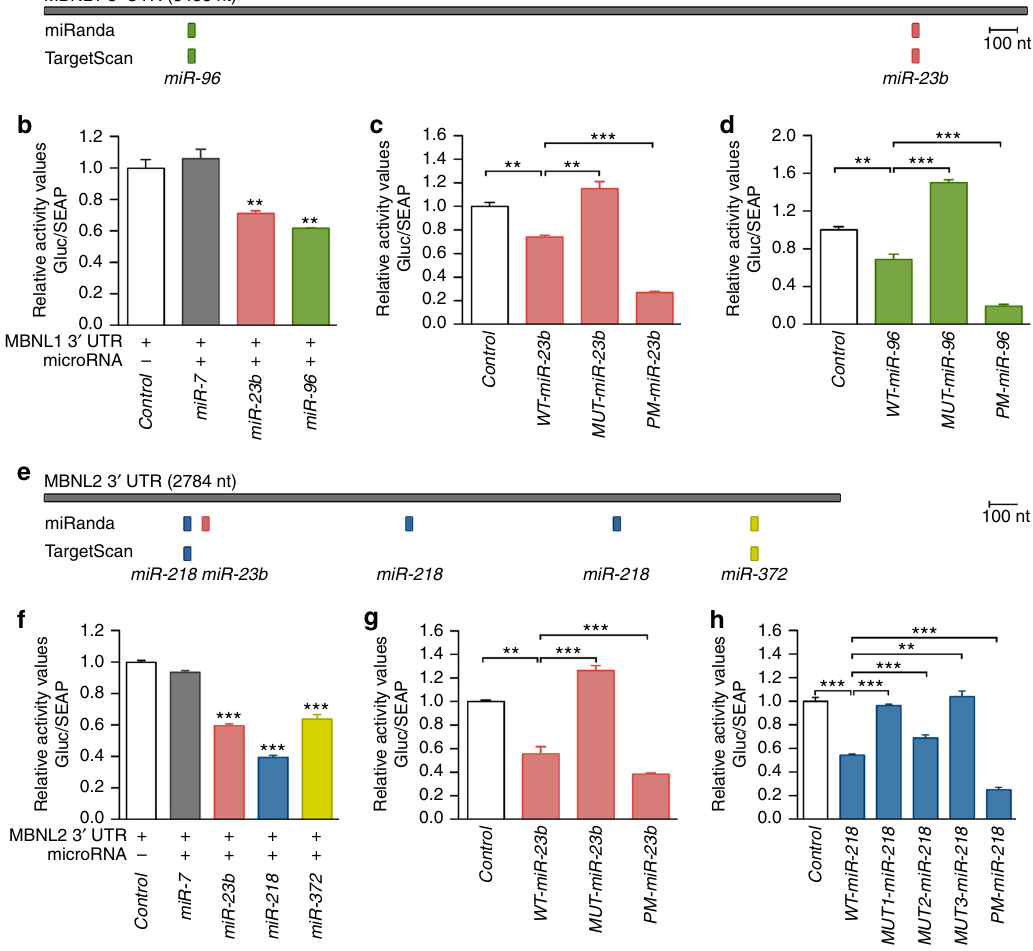
Fig. 2 Con fi rmation of miRNA binding to MBNL1 and MBNL2 3 ′ UTRs. a , e Scale representation of MBNL1 ( a ) and MBNL2 ( e ) 3 ′ UTRs and predicted miRNA binding sites according to miRanda and TargetScan algorithms. MBNL1 ( b – d ) and MBNL2 ( f – h ) 3 ′ UTR luciferase reporter assays of HeLa cells co- transfected with wild-type ( b , f ) or mutated ( c , d , g , h ) versions of 3 ′ UTR fused to Gaussia luciferase and miRNA plasmids ( n = 4). miR-7 was used as a negative control. Wild-type (WT) reporter plasmids had the natural sequence of the miRNA binding sites, mutated (MUT) constructs lacked a candidate miRNA seed region recognition site and the perfect match (PM) versions had the miRNA binding site replaced by the full complementary sequence. ** p < 0.01, *** p < 0.001 according to Student ’ s t test. Data are mean ±